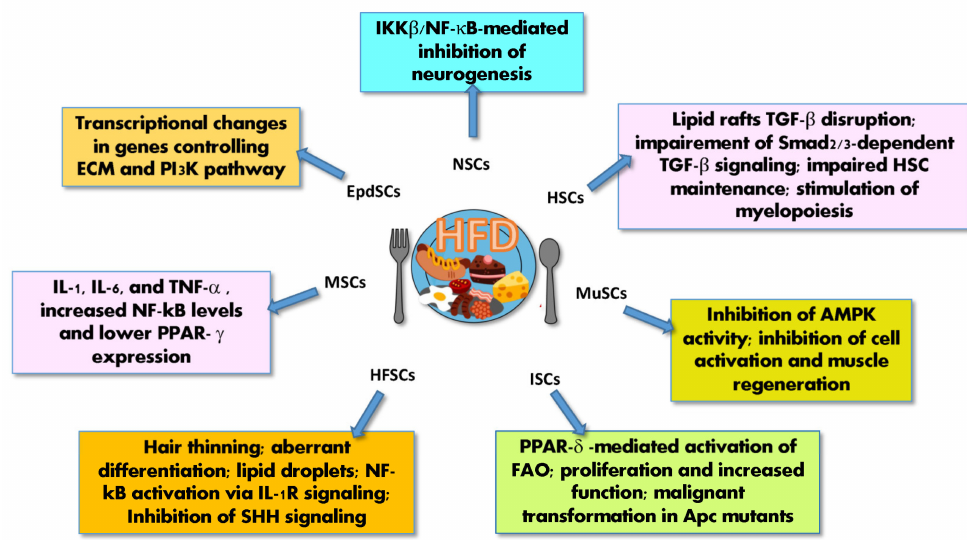
Figure 6. Effects of high fat diet on SCs. Abbreviations: AMPK: 5 (cid:48) adenosine monophosphate-activated protein kinase; Apc: adenomatous polyposis coli; ECM: extracellular matrix; EpdSCs: epidermal stem cells; HFSCs: hair follicle stem cells; HSCs: hematopoietic stem cells; IKK β : IkappaB kinase; IL-1: Interleukin-1; IL-6: Interleukin-6; IL-1R: Interleukin-1 receptor; ISCs: intestinal stem cells; MSCs: mesenchymal stem cells; MuSCs: muscle stem cells; NF- κ B: nuclear factor kappa B; NSCs: neural stem cells; PI3K: phosphatidyl-inositol-3-kinase; PPAR- δ : peroxisome proliferator-activated receptor δ ; PPAR- γ : peroxisome proliferator-activated receptor γ ; SHH: sonic hedgehog; Smad2/3: small mother against decapentaplegic 2/3; TGF- β : transforming growth factor β ; TNF- α : tumor necrosis factor α